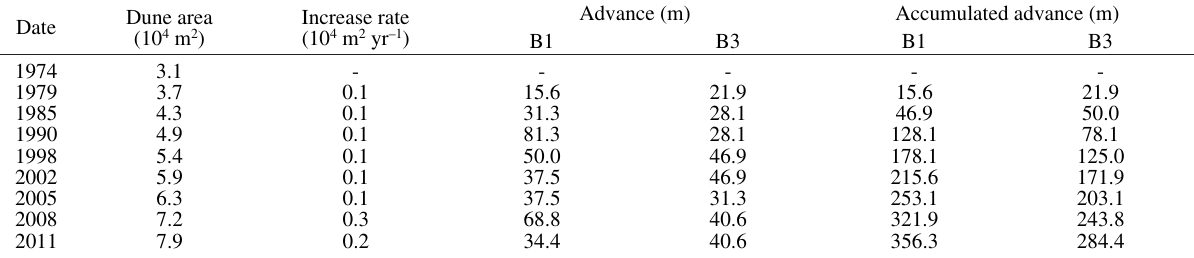
Table 2. – Dune area and advance rates for Bolonia profiles B1 and B3 from 1974 to 2011.